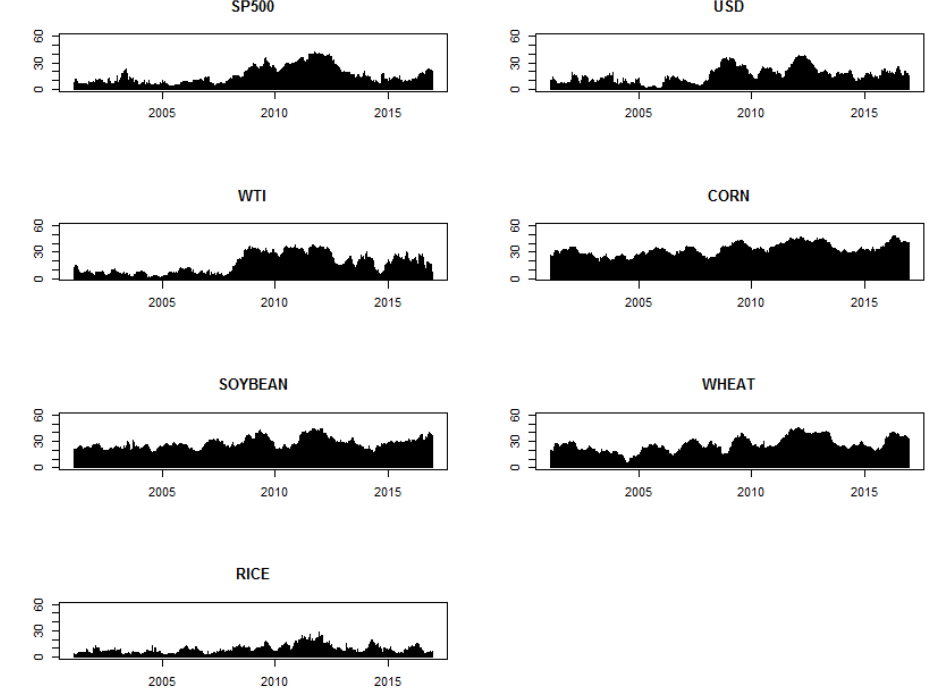
Figure 4: Directional volatility spillovers “from others” for seven markets (the lasso method)